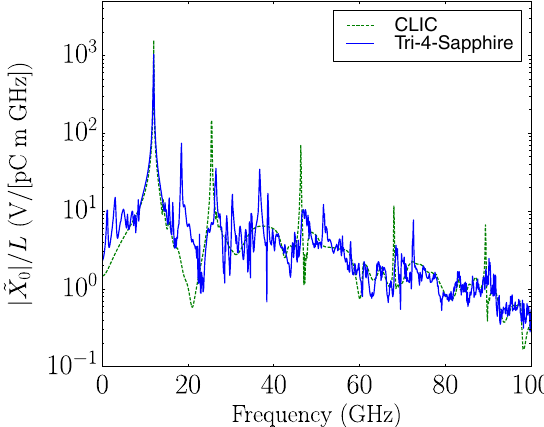
FIG. 6. Monopole HOMs are relatively numerous in the Tri-4- Sapphire cavity, but occur at lower amplitudes.